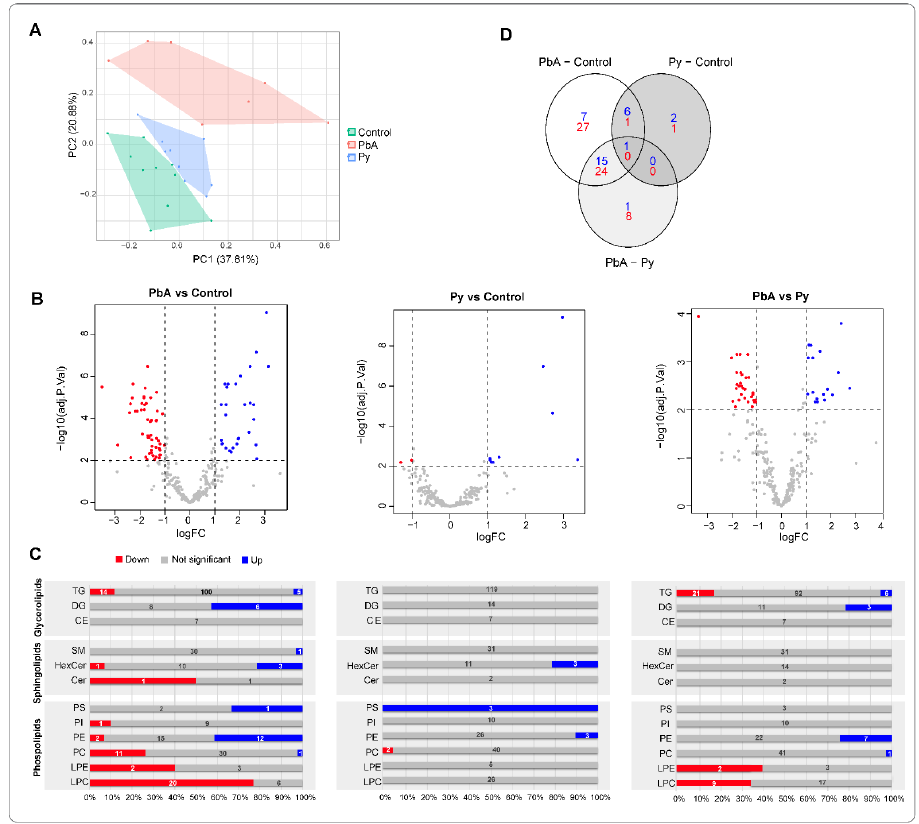
Figure 3. Differentially expressed lipids. ( A ) Principal component analysis (PCA) of identified lipids (pmol/µL). ( B ) Volcano plots showing differentially expressed lipids in the various pairwise com- parisons. ( C ). Bar charts representing the proportion of differentially expressed ions across each lipids (pmol/ µ L). ( B ) Volcano plots showing differentially expressed lipids in the various lipid graph. Blue, grey and red bars show the percentage of elevated, not significant and decreased level of lipid molecules in each type. Numbers on top show the actual number of differentially ex- pressed ions in each type. ( D ) Venn diagram of the distribution of differentially expressed lipids in the various comparisons. Significance is based on two-fold increase or decrease in lipid amounts plus an adjusted p -value < 0.01 based on moderated t -test and false discovery rate (FDR) correction.